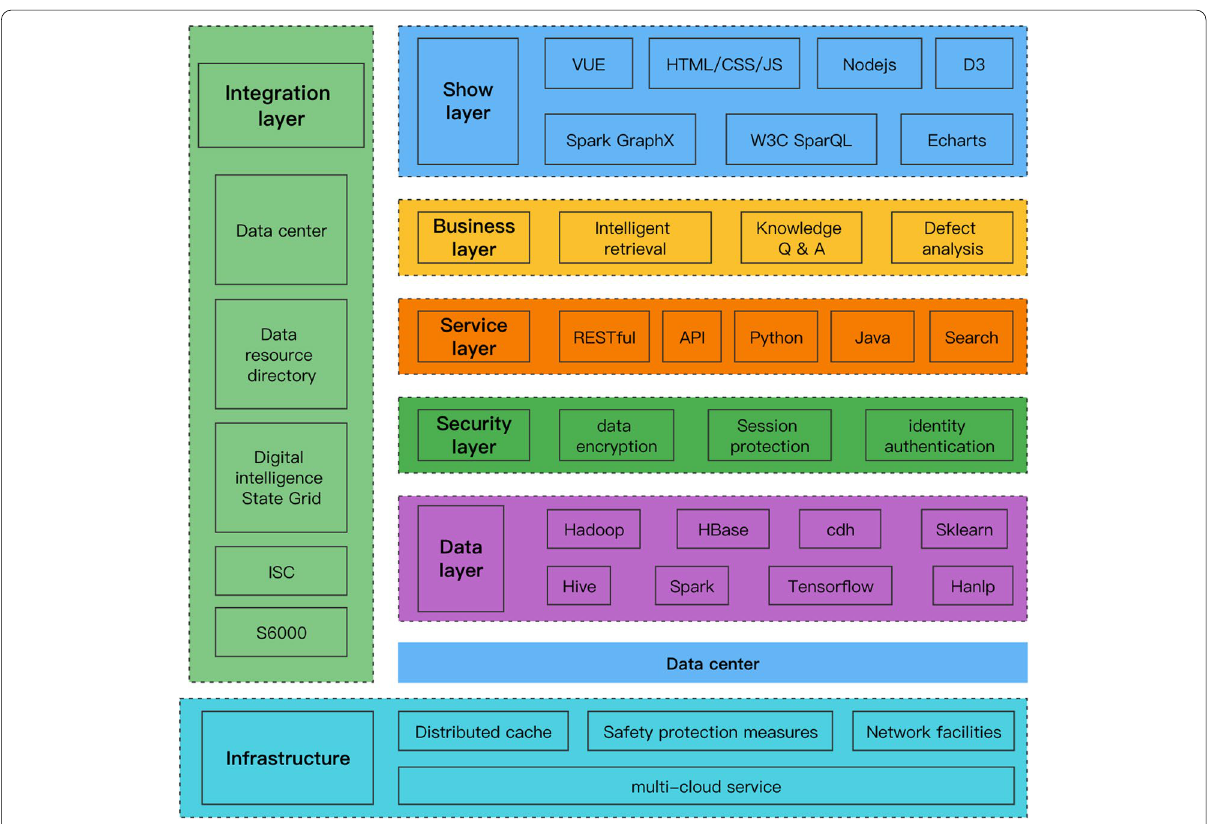
Fig. 3 Technical framework of power equipment defect